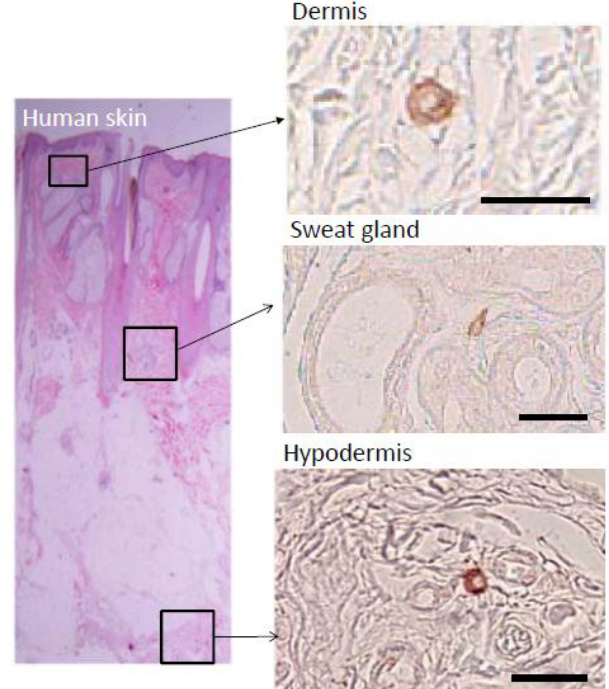
Figure 2. Localization of Muse cells in adult human